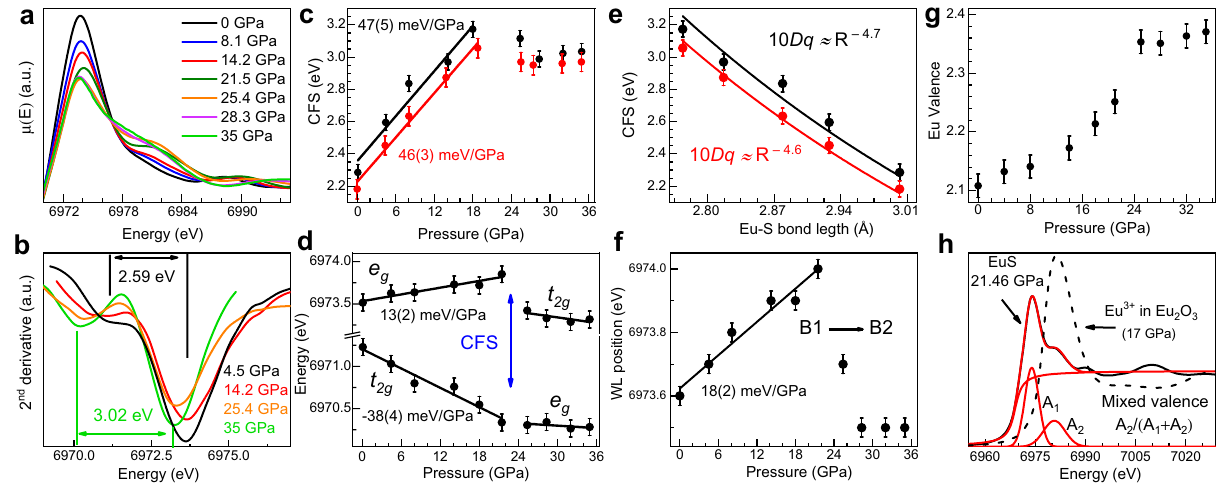
Figure 4. ( a ) XANES spectra between 0 to 35 GPa. ( b ) Pressure evolution of ∂ 2 µ( E )/∂ E 2 showing the minima whose energetic separation corresponds to the CFS as indicated ( c ) experimental (black dots) and theoretical (red dots) CFS versus pressure. ( d ) Experimentally derived energetic position of the Eu 5 t 2 g and 5 e g orbitals versus pressure. ( e ) Observed (black dots) and theoretical (red dots) CFS versus Eu-S bond length in the B1 phase. ( f ) Observed pressure evolution of the WL position. ( g ) Experimental Eu valence state under lattice contraction. ( h ) Spectral weight approach to obtain the oxidation state. The XANES spectra were fit by arctan + two Gaussians. The areas A 1 and A 2 of the Gaussians fitted to the absorption spectrum are related to the relative fraction of Eu 2 + and Eu 3 +